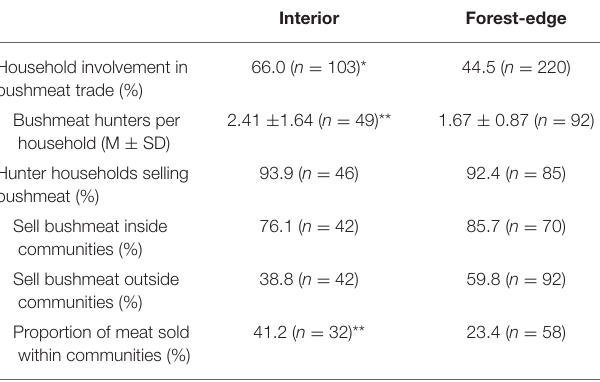
TABLE 4 | Participation in bushmeat hunting and trade, by forest proximity. TABLE 3 | Food security and nutritional status, by forest proximity. Interior Forest-edge